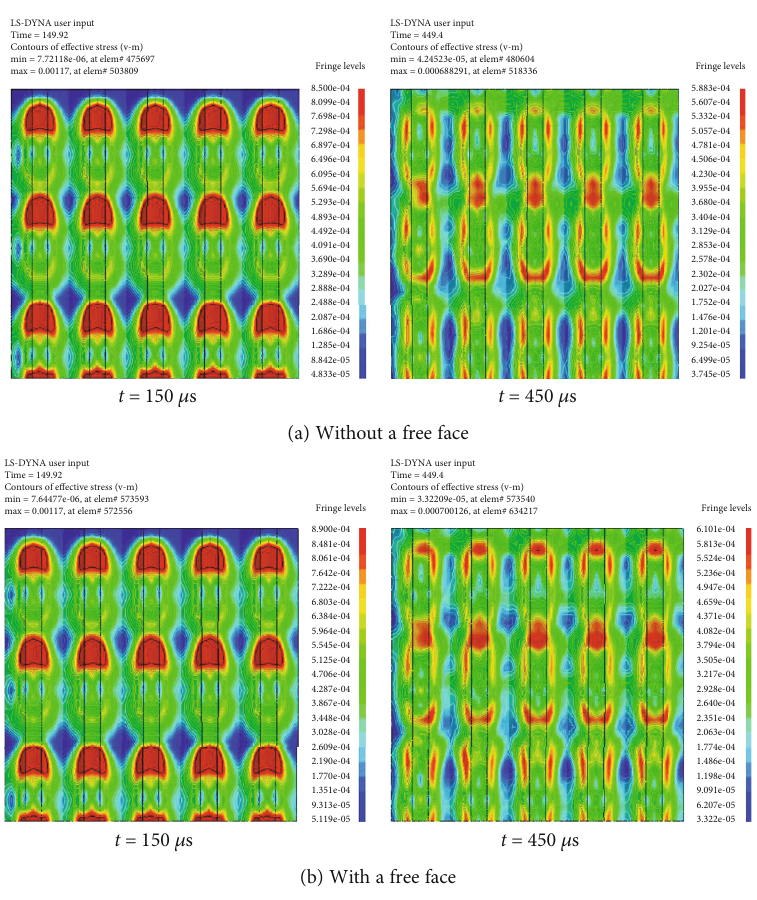
Figure 20: E ff ective stress cloud images of cross section A-A in the